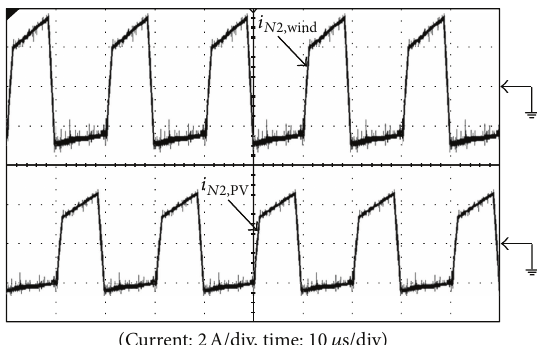
Figure 24: Measured waveforms of switch